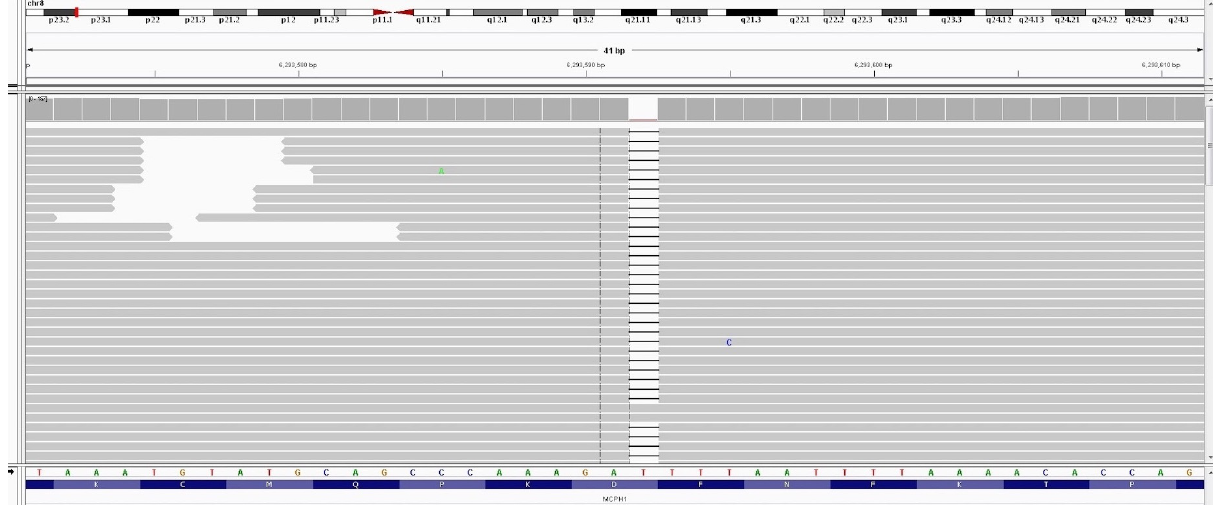
Figure 1. IGV screenshot for mutations in the MCPH1 gene. The mutation c.348del in the MCPH1 gene